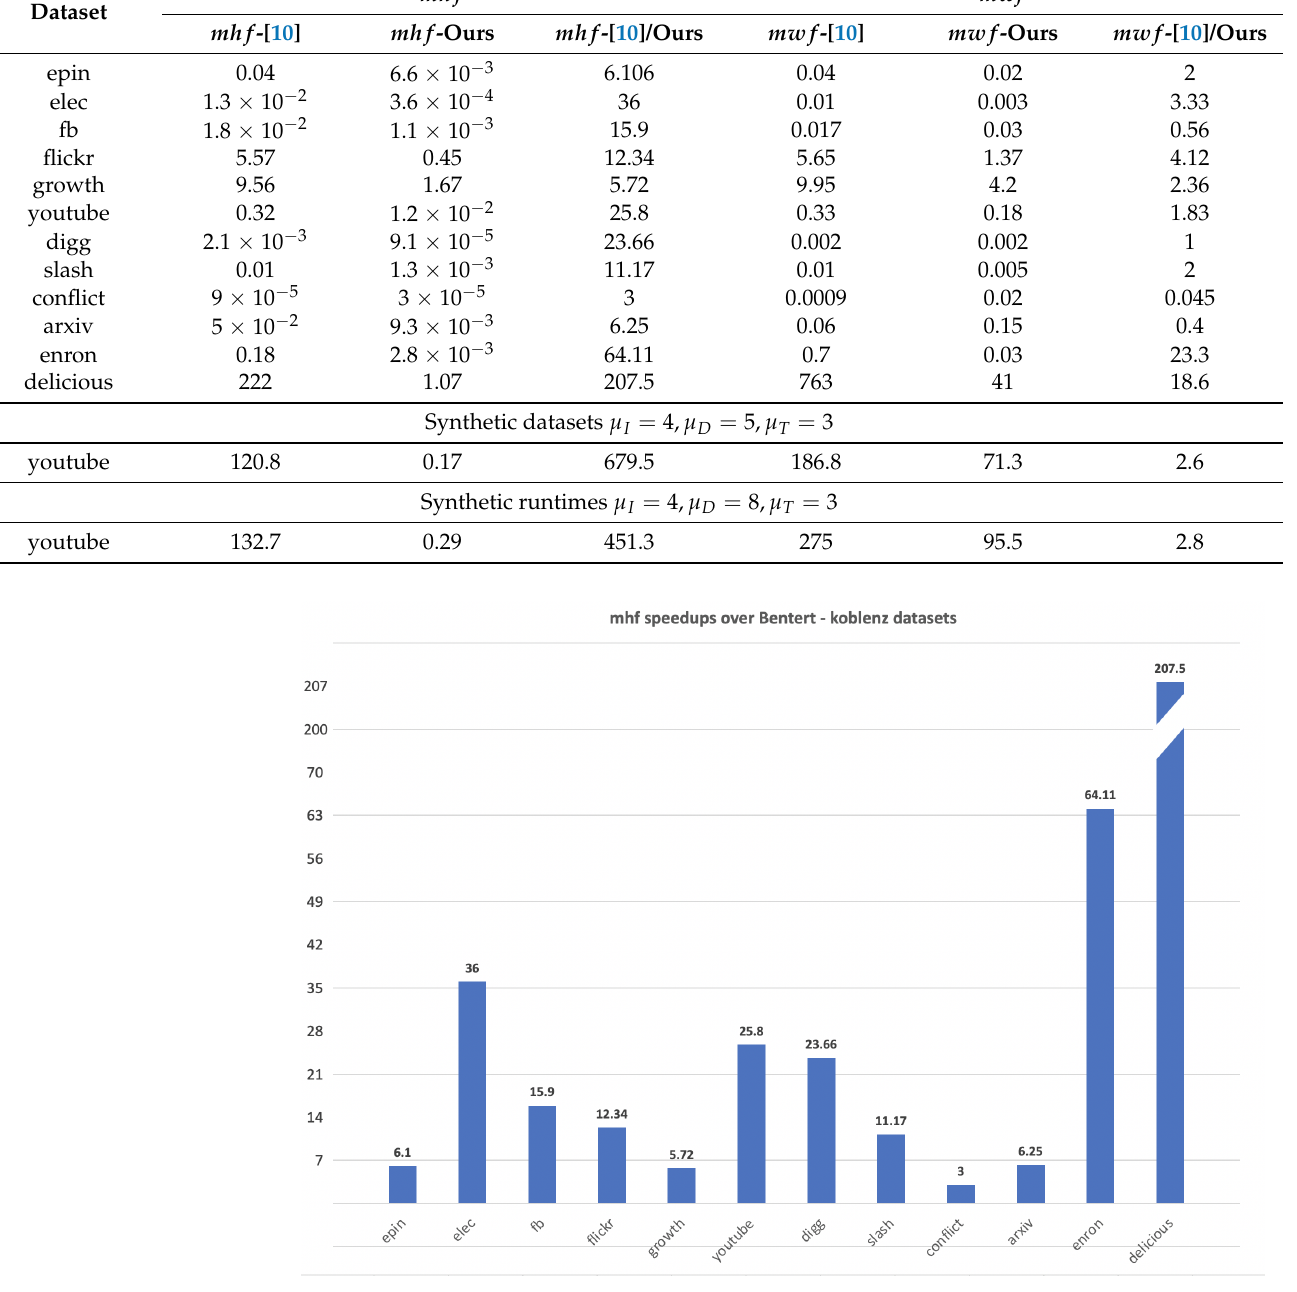
Figure 13. mhf speedups on Koblenz